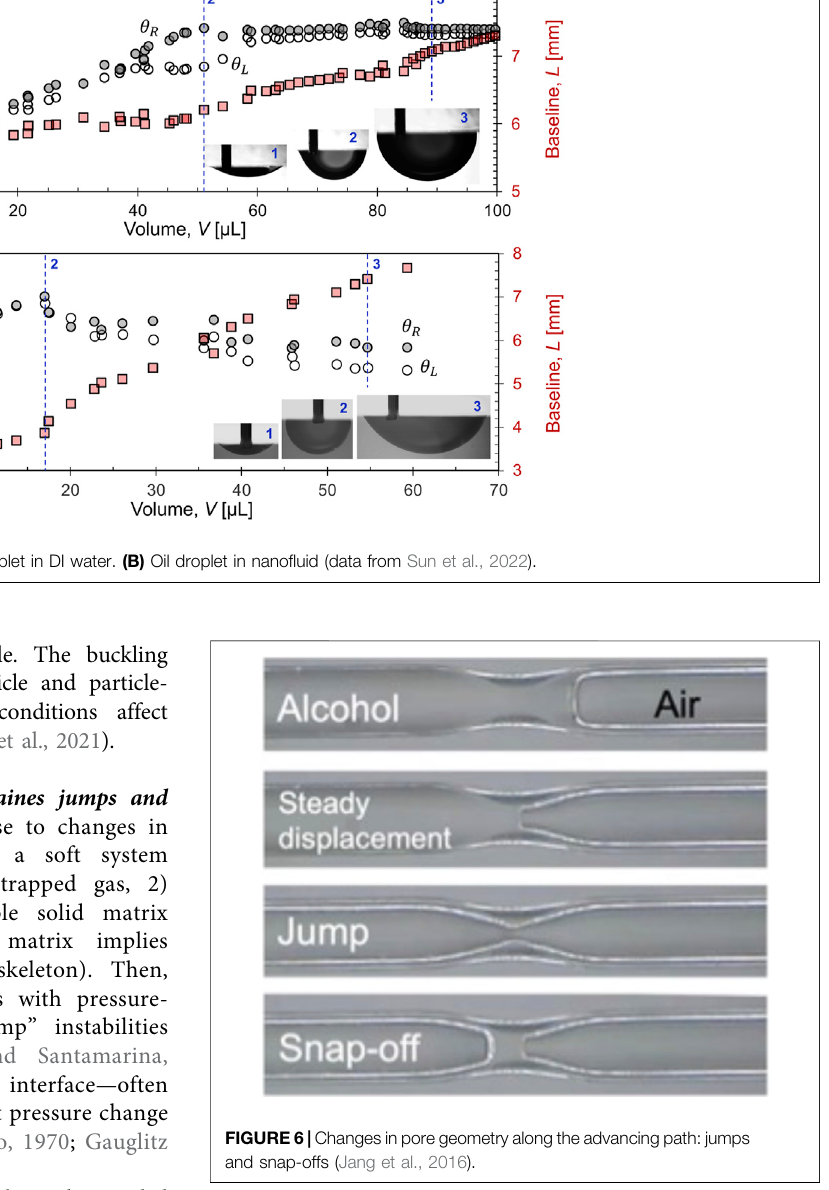
Frontiers in Mechanical Engineering |